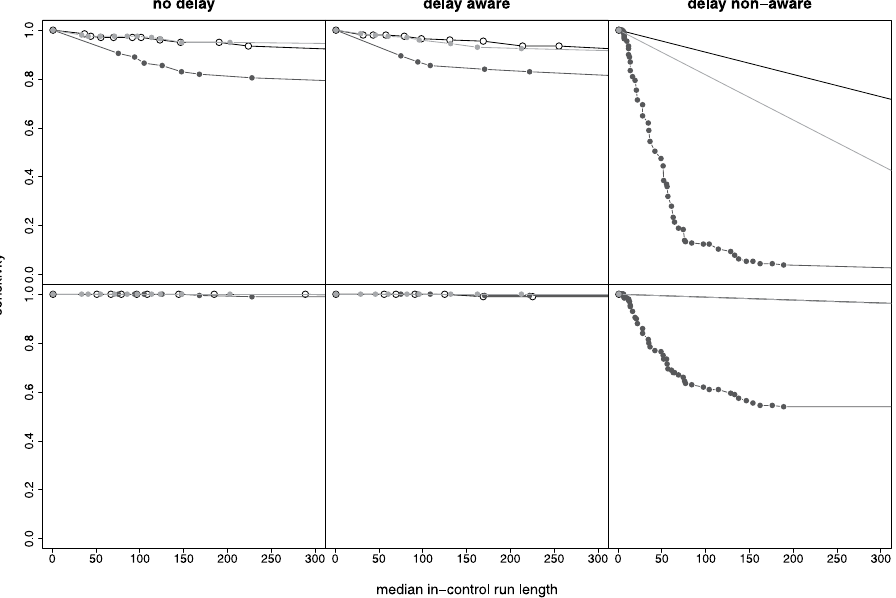
Figure 7. Influence of the choice of expert knowledge on the performance (sensitivity, in-control ARL) of detecting smaller (top row) and larger (bottom row) outbreak types under the V-based approach. Perfect expert knowledge was based on an ideal distribution of expected outbreak-related mortality cases (empty circles) for the given outbreak type. Non-perfect expert knowledge was simulated with expected outbreak distribution being biased either towards larger, steeply increasing outbreaks (black circles) or smaller, slowly increasing outbreaks (grey circles). Results are shown for combined mortality syndromes